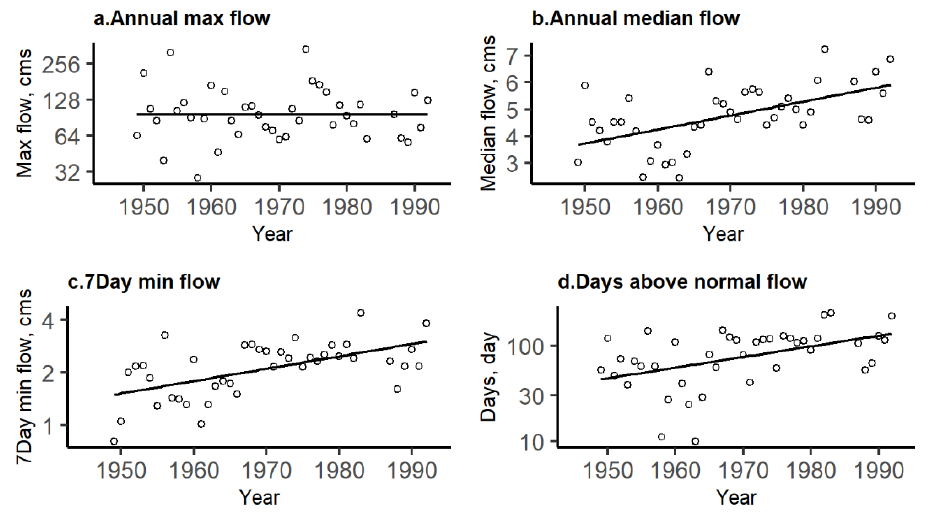
Figure 6. Streamflow regime of the Erindale (urban) gauge located in the main channel. ( a ) Annual max flow, ( b ) Annual median flow, ( c ) 7-day min flow, ( d ) Days above normal